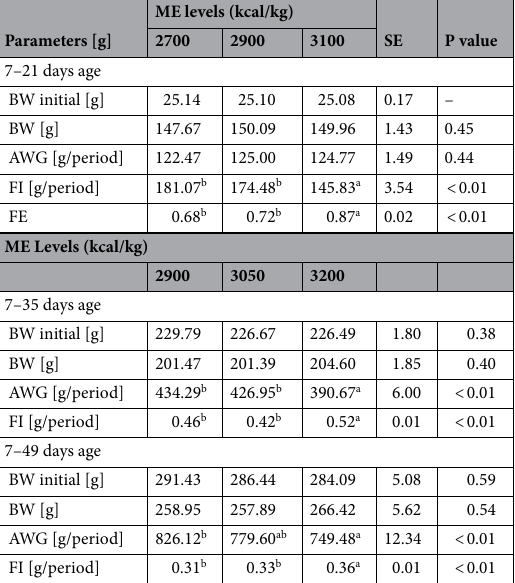
Table 1. Performance of European quail meat as a function of metabolizable energy levels (kcal ME/kg). SE: Standard error of the mean; Means followed by different letters on the same line differ by Tukey’s test at